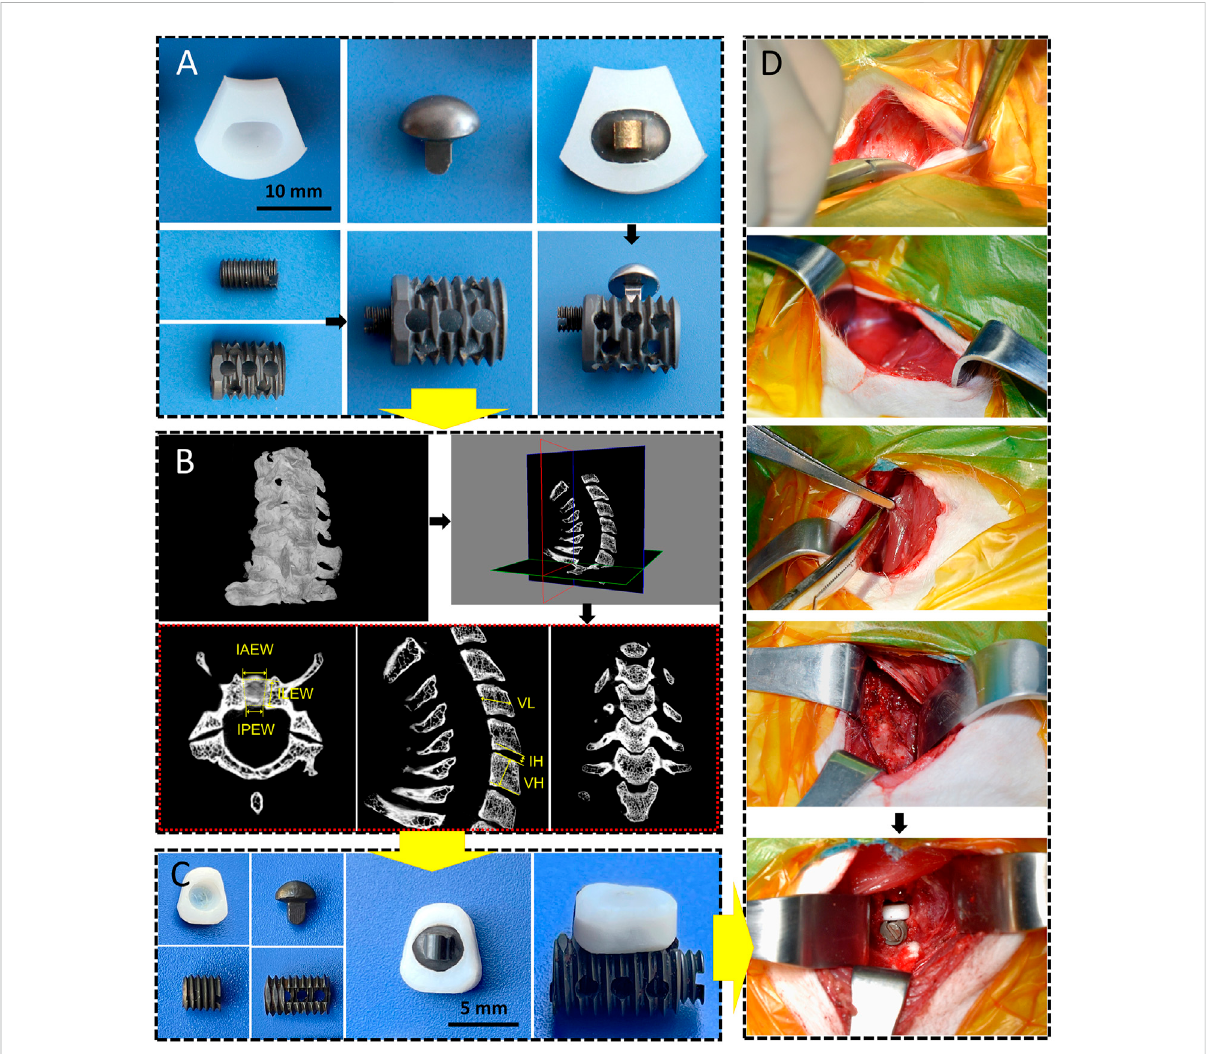
FIGURE 1 CSDPdesign,improvement,andimplantation. (A) Thecervicalsubtotaldiscectomyprosthesis(CSDP)design.Fourcomponents:CDPstructure, link structure, CVF structure, and locking screw. (B) Cervical spine micro-CT anatomical measurements in transverse, sagittal, and coronal planes. IAEW, intervertebral anterior edge width. IPEW, intervertebral posterior edge width. ILEW, intervertebral lateral edge width. IH, intervertebral